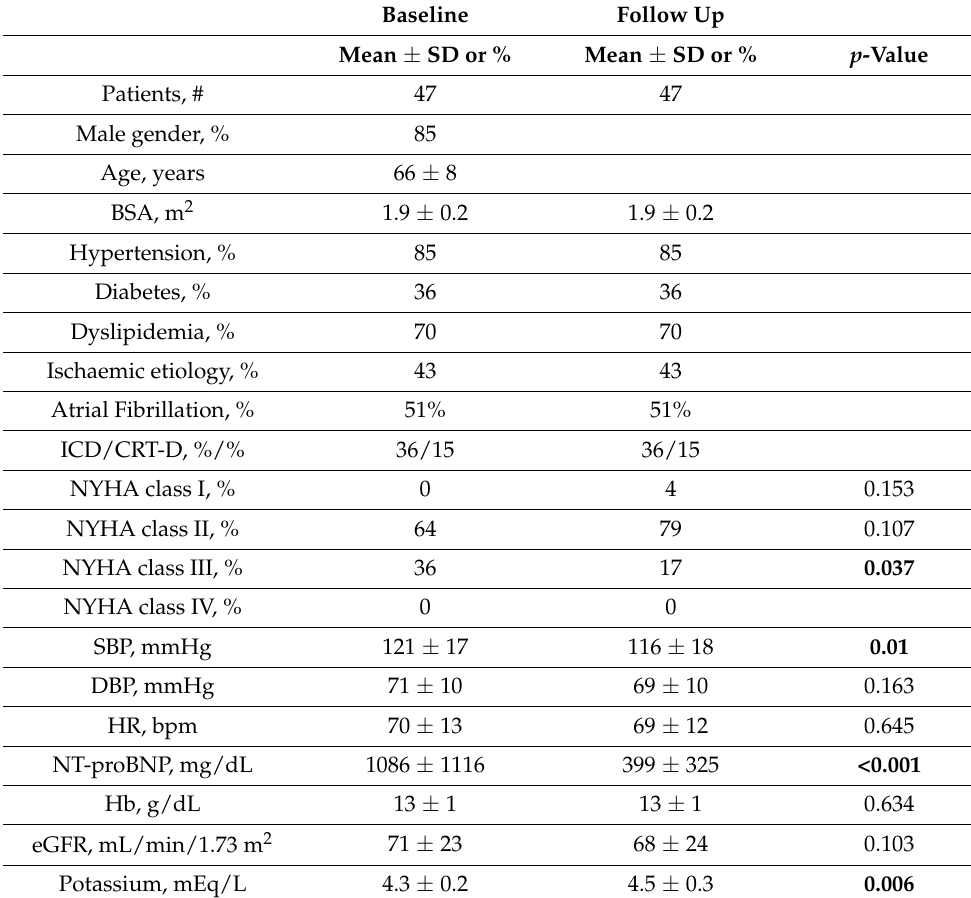
Table 1. Patients’